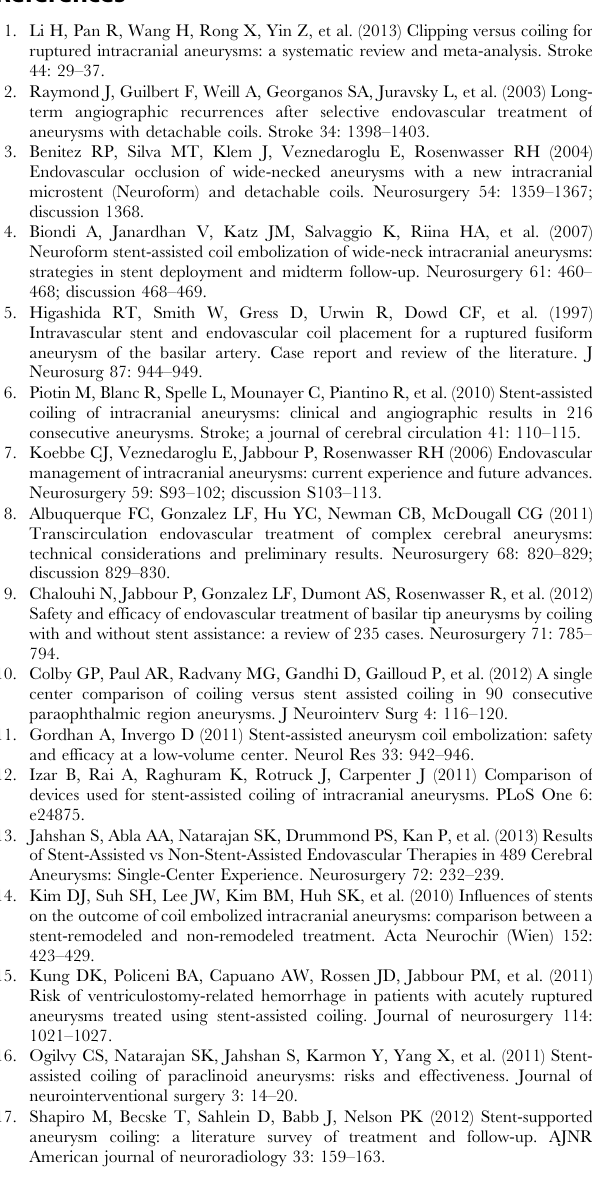
Figure S1 Forest plot of immediate occlusion rate comparing stent-assisted coiling versus coiling only . Fixed-effect model was applied. (TIF) Figure S2 Forest plot of mortality rate comparing stent- assisted coiling versus coiling only . Random-effect model was applied. (TIF) Figure S3 Forest plot of permanent complication rate comparing stent-assisted coiling versus coiling only. Fixed-effect model was applied. (TIF)